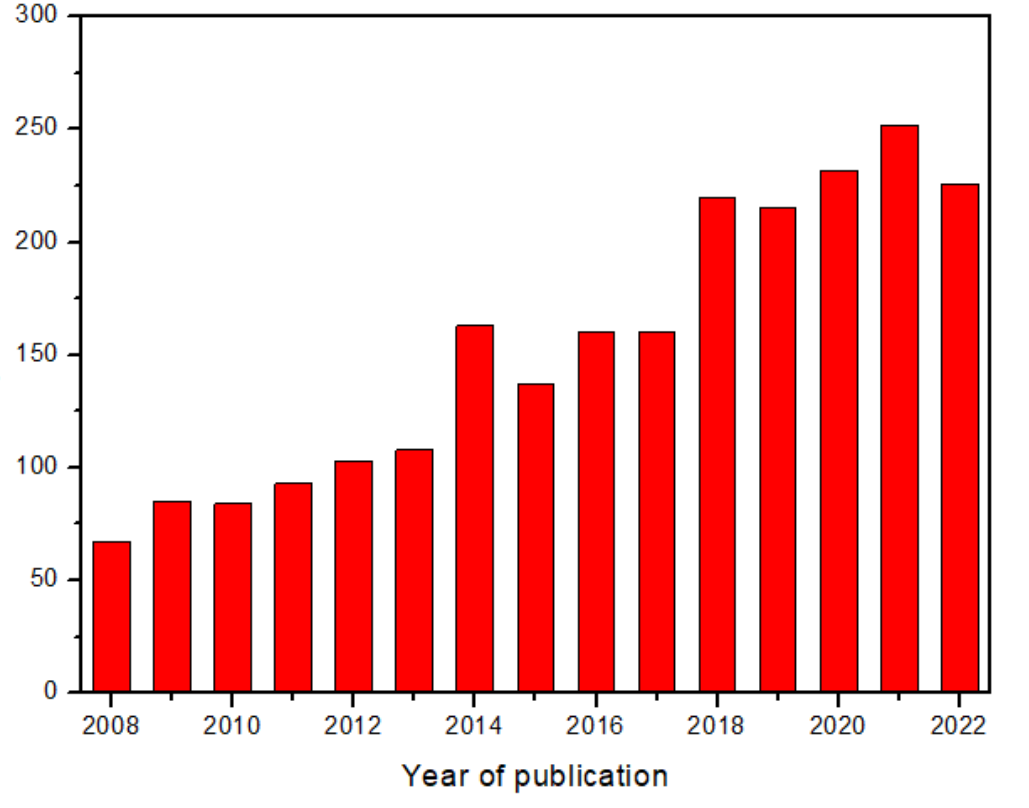
Figure 1. Trends in scientific publications focused on reinforcement permeability in the last fifteen years (2008 – 2022) [25].